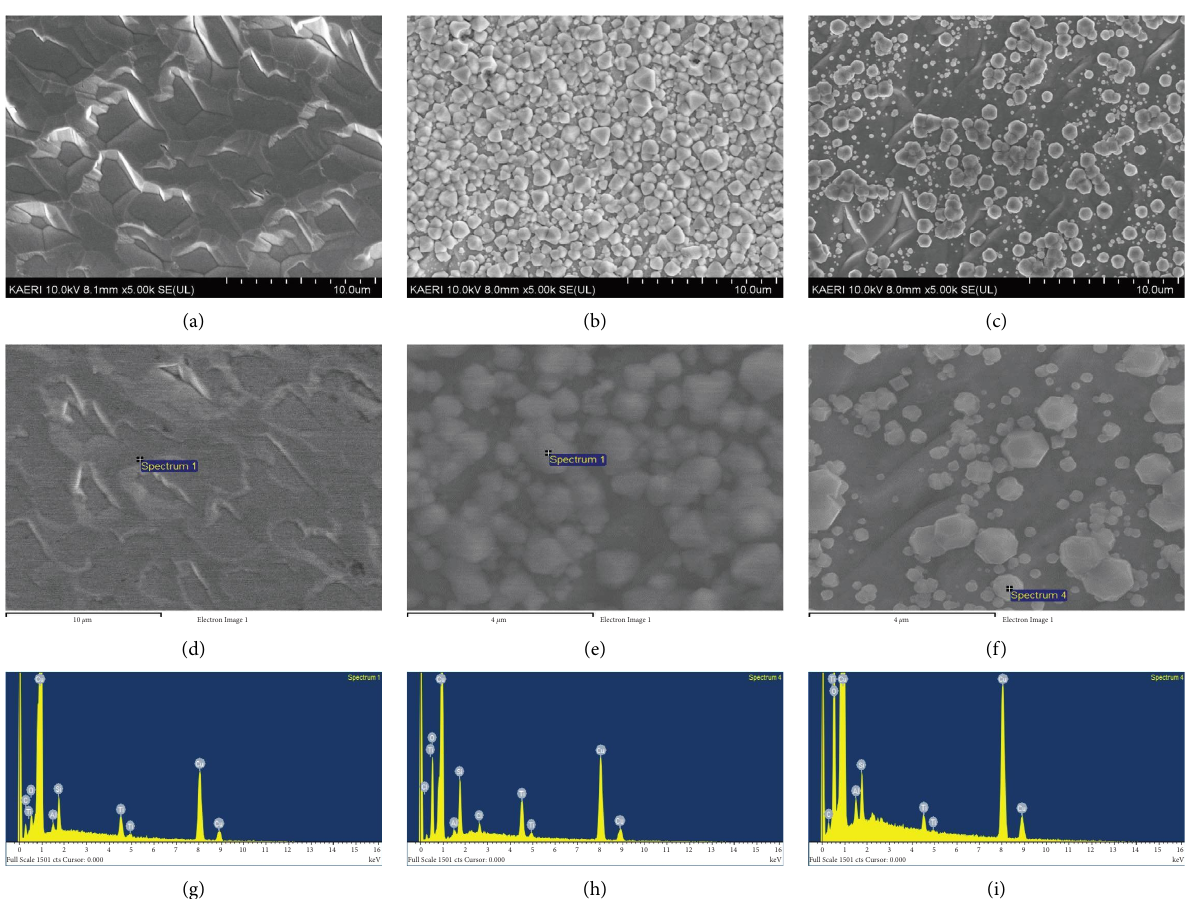
Figure 5: SEM/EDS analysis of (a), (d), (g) bare Cu, (b), (e), (h) Cu immersed in oxic KURTgroundwater, and (c), (f), (i) Cu immersed in 0.1M NaCl − added oxic KURT